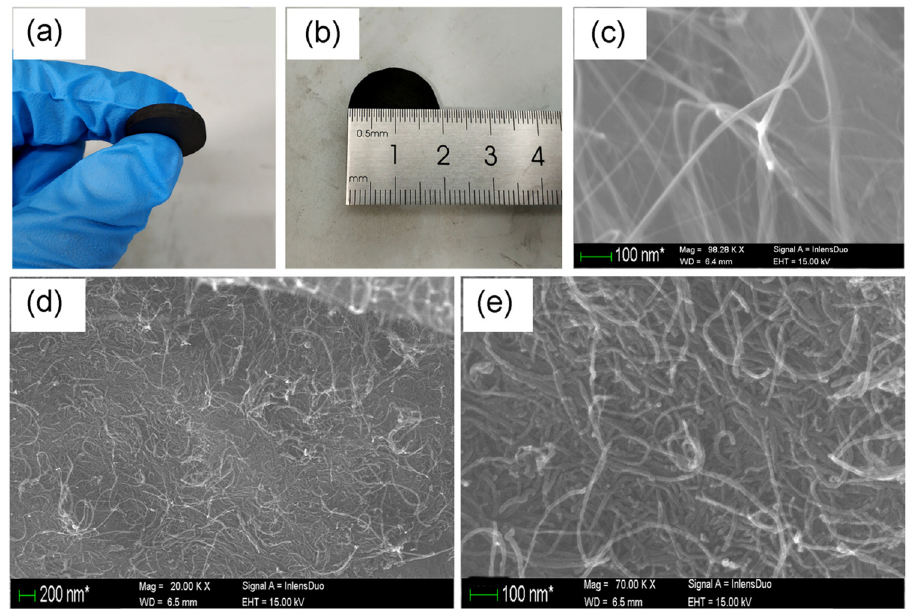
Figure 1: ( a ) and ( b ) SPS sintered SWCNT blocks; ( c ) scanning electron microscopy ( SEM ) image of the polished surface; ( d ) and ( e ) low - resolution and high - resolution SEM image showing fracture surfaces of the bulk SWCNT